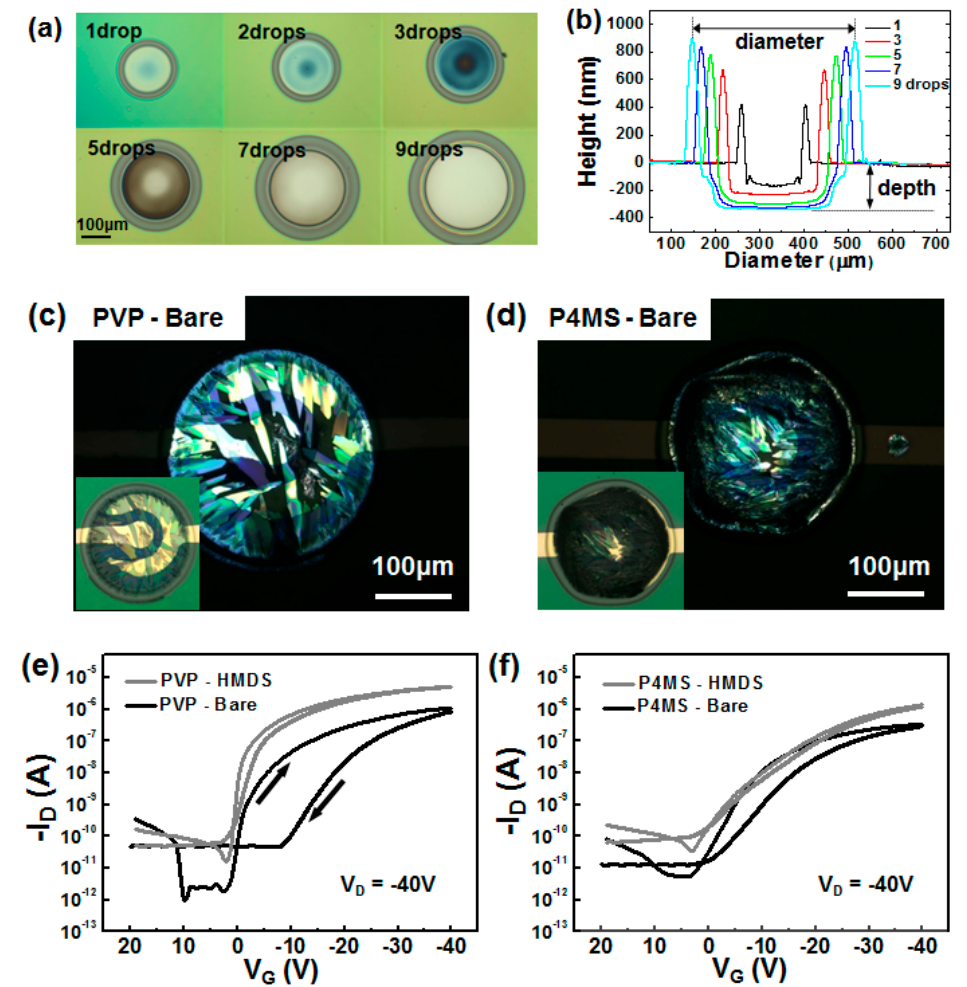
Figure 10. ( a ) Optical microscopy images and ( b ) height profiles of inkjet-etched PVP films for various numbers of printed ethanol droplets. Polarized optical microscopy images of 6,13-bis(triisopropylsilylethynyl)pentacene (TIPS_PEN) crystals that have been inkjet printed on a PVP bank ( c ) and a poly(4-methyl styrene) (P4MS) bank ( d ). Electrical properties of triisopropylsilylethynyl pentacene (TIPS_PEN) thin-film transistor (TFTs) on the PVP bank ( e ) and the P4MS bank ( f ). The term ‘bare’ indicates a SiO 2 dielectric without surface treatment and ‘HMDS’ indicates a hexamethyldisilazane-treated SiO 2 dielectric [28]. Copyright 2013 Wiley.